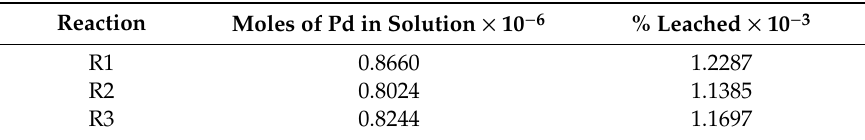
Table 10. Moles of Pd in catalyst leached after each reaction cycle.